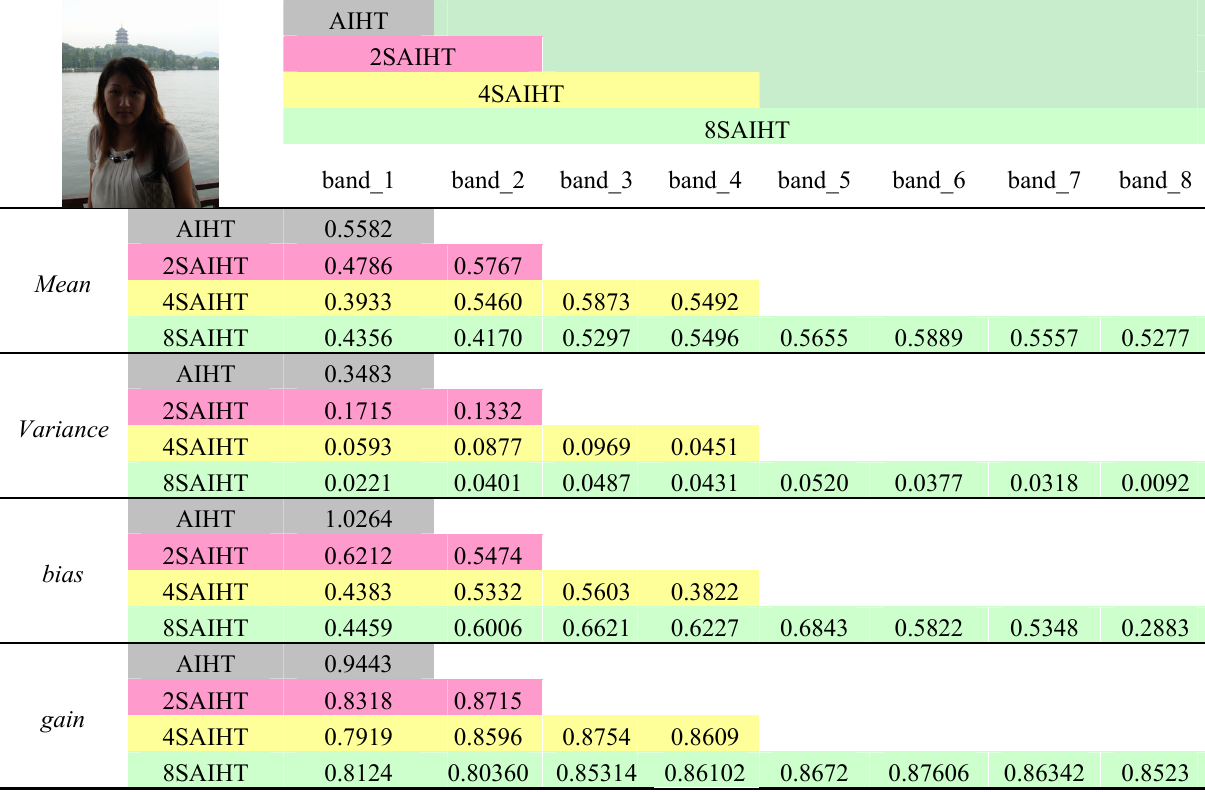
Table 2. Parameter values of various scales of MSAIHT (including 2SAIHT, 4SAIHT and 8SAIHT).